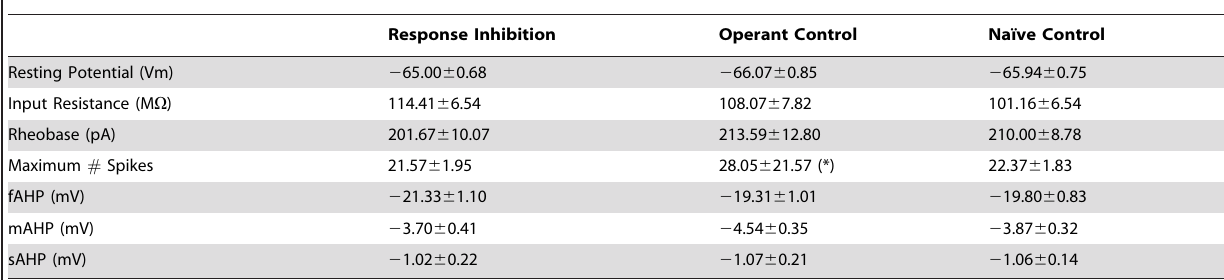
Table 2. Characteristics of infralimbic neurons.